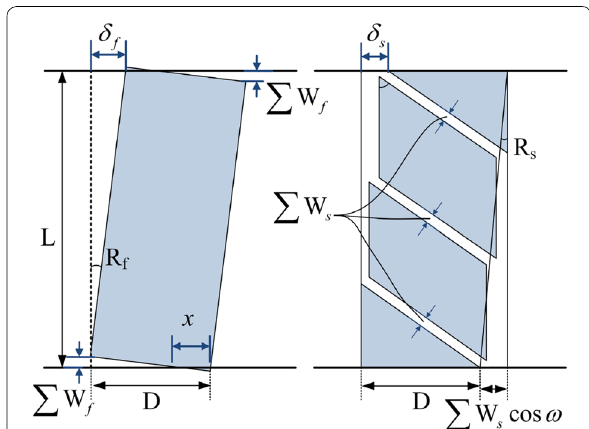
Fig. 2 Simplified crack‑deformation model of column. (AIJ